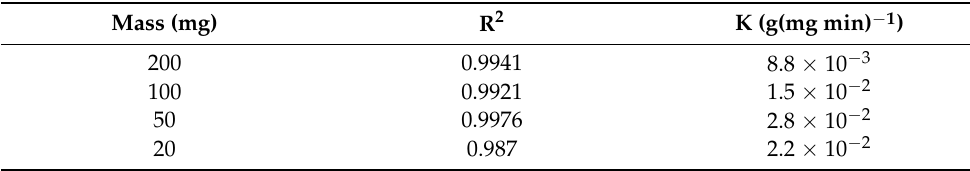
Table 2. The PSO parameters of RhB with Fe-MOFs of different masses.